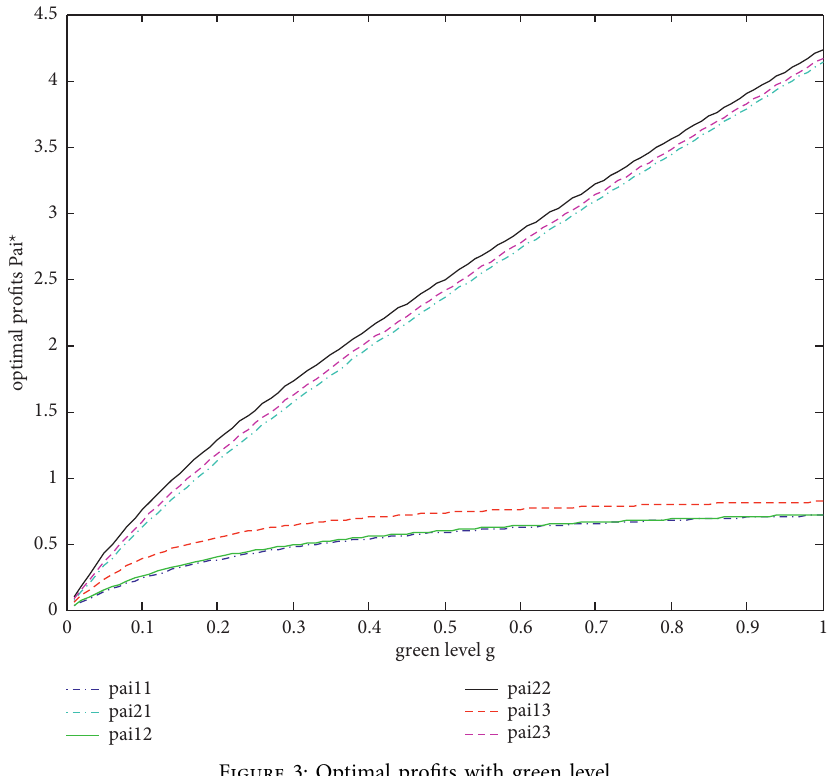
Figure 3: Optimal profits with green